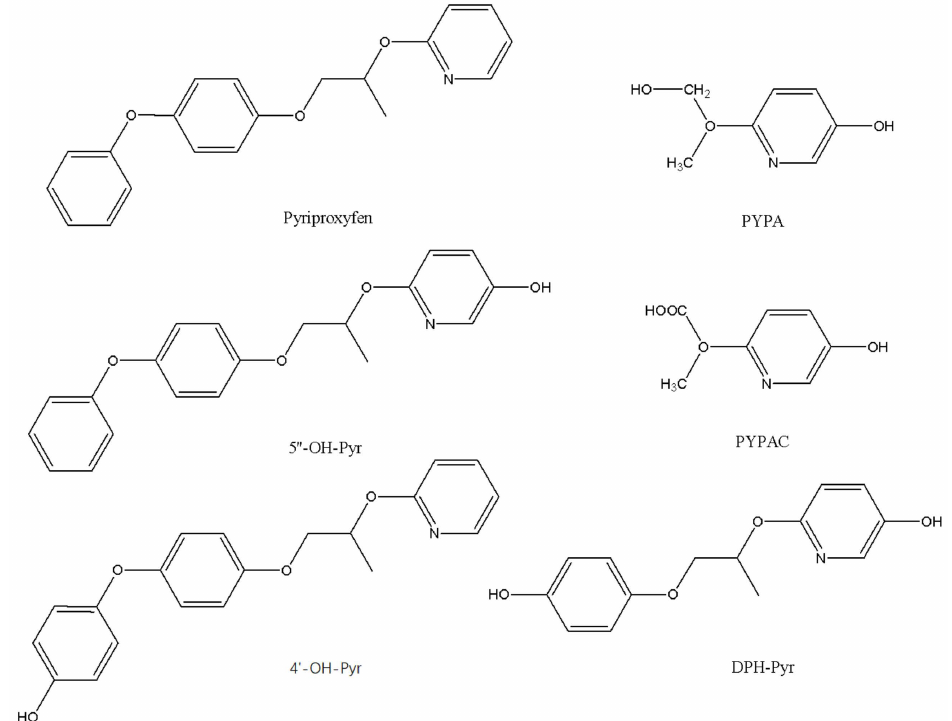
Figure 1. The chemical structures of pyriproxyfen and its metabolites PYPA, PYPAC, DPH-Pyr, 5 (cid:48)(cid:48) -OH-Pyr and 4 (cid:48) -OH-Pyr. Standard stock of pyriproxyfen and its five metabolites at a concentration of 200 mg/L was obtained by accurately weighing quantities of 0.0100 g of pyriproxyfen and its five metabolite standards and dissolving them in 50 mL volumetric flasks with MeCN, respec- tively. Then, they were stored at − 20 ◦ C until